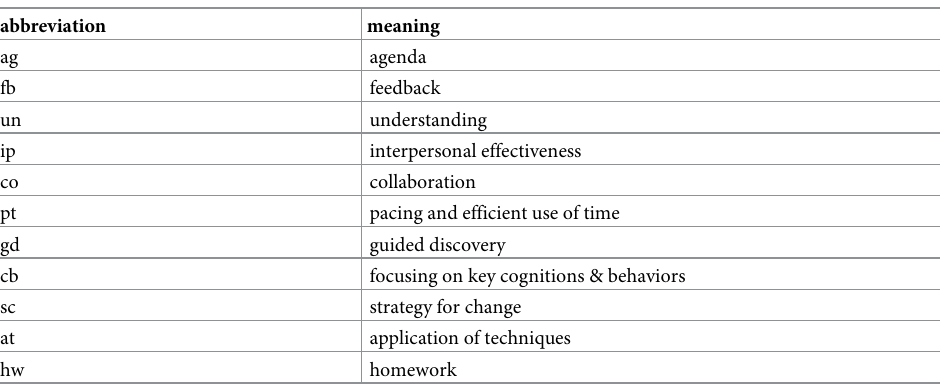
Table 1. The 11 CBT quality codes defined by CTRS.